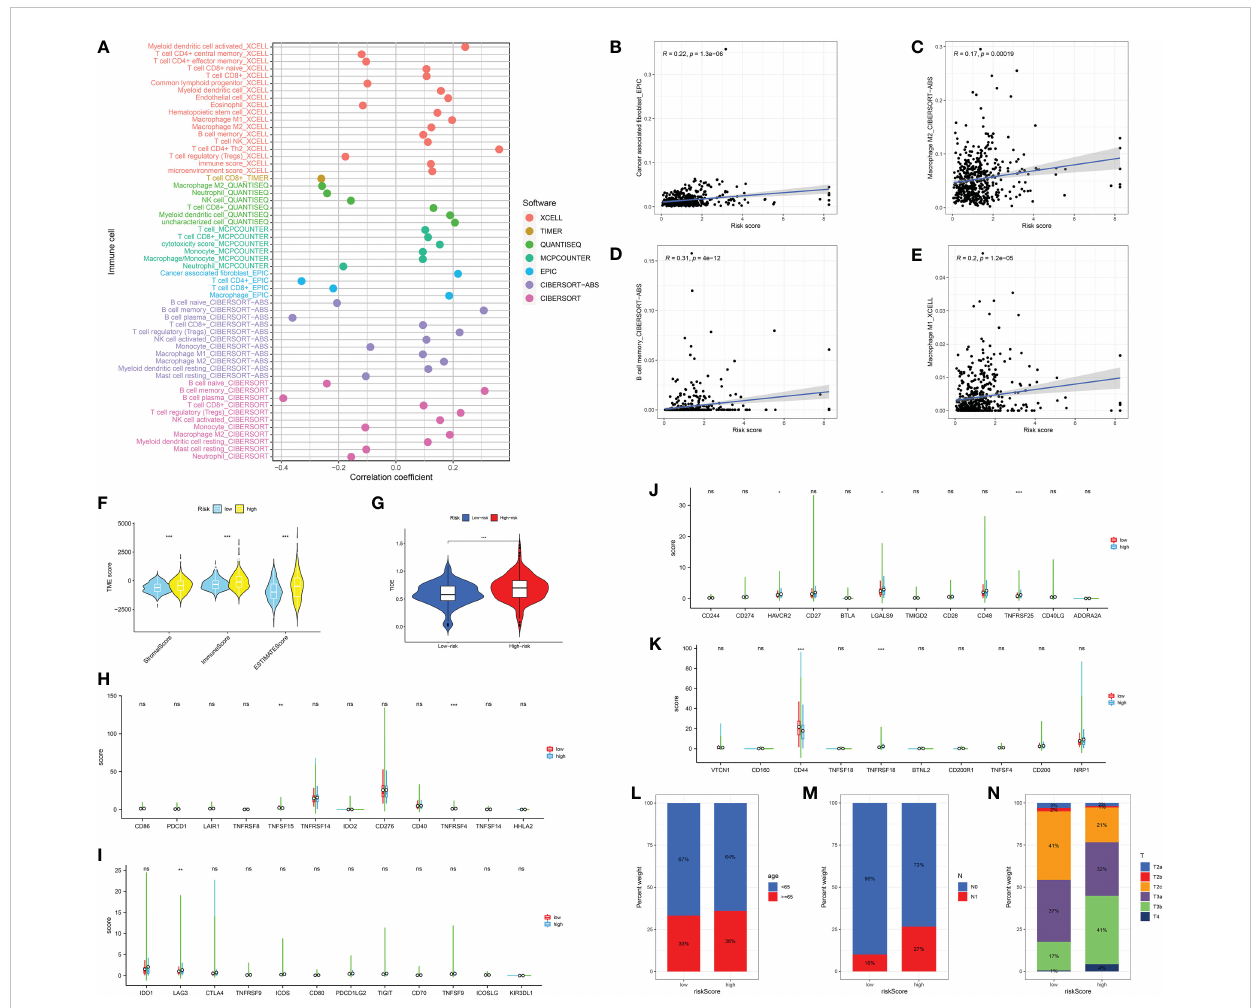
FIGURE 5 (A) The correlation analysis between immune cell in fi ltration and risk score; The correlation between risk score and CAFs (B) ; M2 macrophages (C) ; Memory B cell (D) ; M1 macrophages (E) ; (F) The association between risk score and immune-related score; (G) The correlation analysis between TIDE score and risk score; (H-K) The correlation between immune checkpoint-related genes and risk score; The correlation analysis between risk score and age (L) ; N stage (M) ; T stage (N) . *: p<0.05; **: p<0.01; ***: p<0.001, ns: